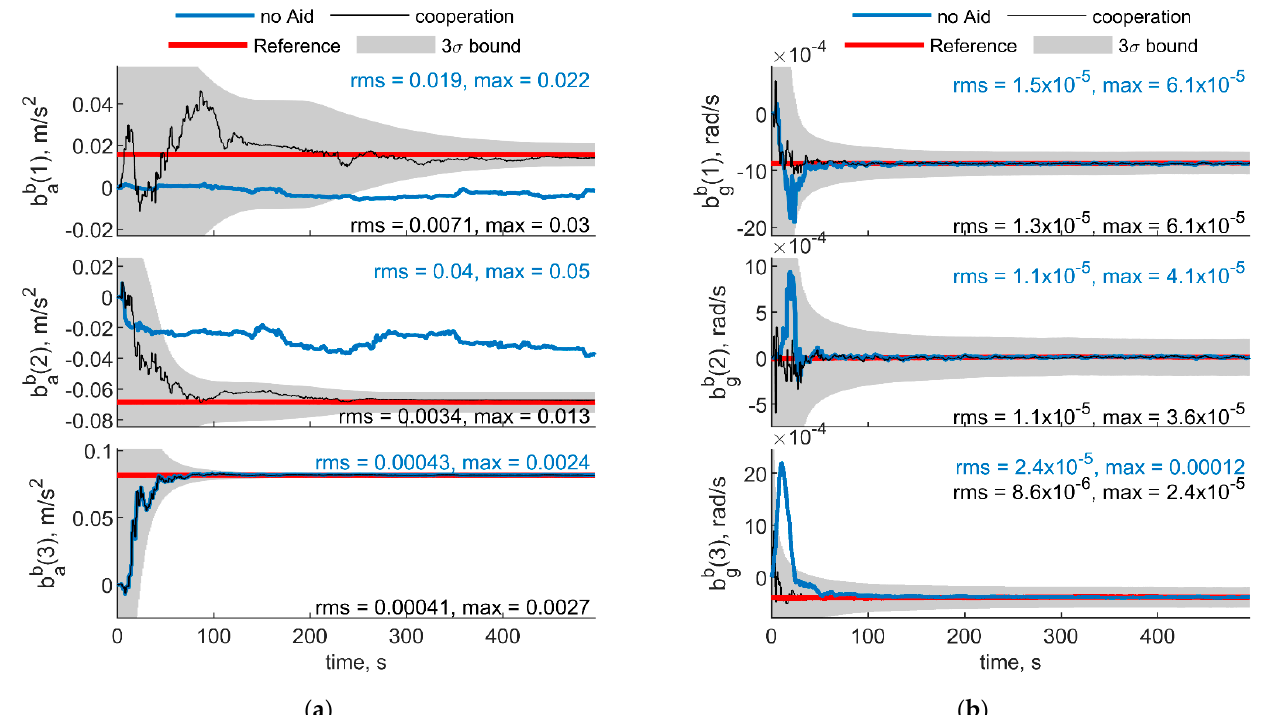
Figure 14. ( a ) Accelerometer and ( b ) gyroscope biases predicted by the filter. One deputy. Chief and deputy move along UAV 1 and UAV 2 trajectories reported in Figure 13, respectively. Reference value is reported in red. Results obtained with cooperation and without cooperation have been reported in black and blue, respectively. RMS and maximum error value have been evaluated starting from t = 60 s.